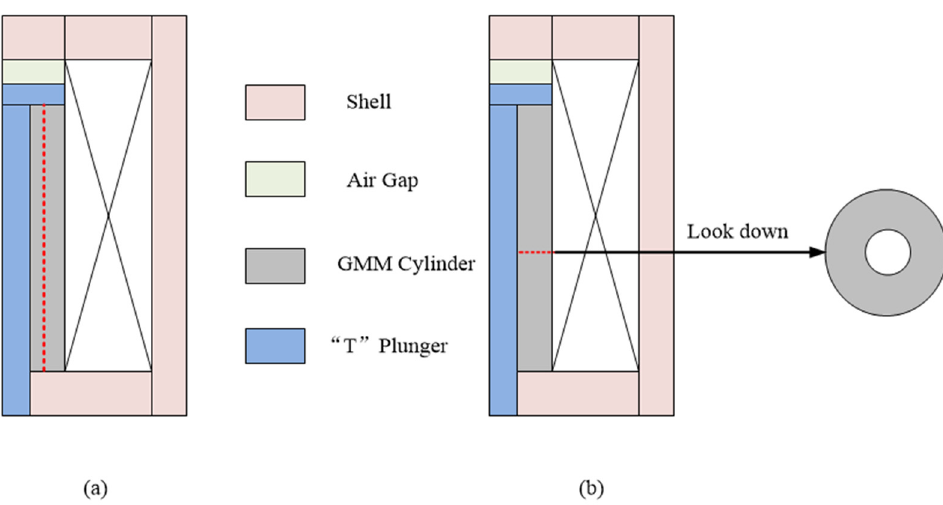
Figure 7. ( a ) The magnetic field intensity on an axis of the cylinder taken as the research object; ( b ) the magnetic field intensity of a section on the cylinder taken as the research object.